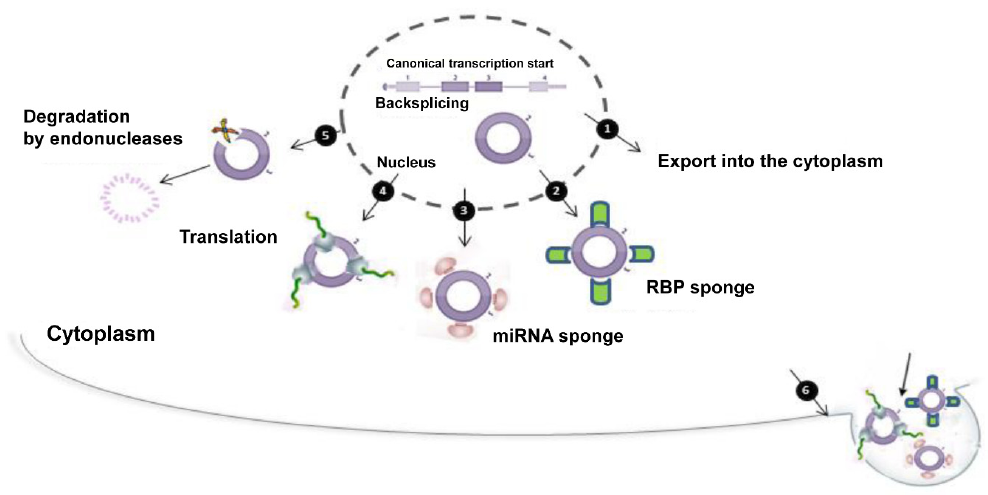
Figure 6. CircRNAs at a glance. Starting from a canonical mRNA, circRNA biogenesis starts